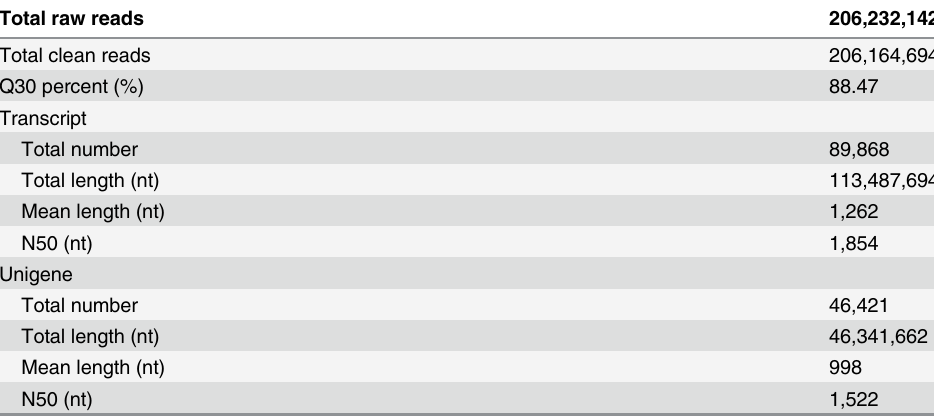
Table 1. Overview of the sequencing and